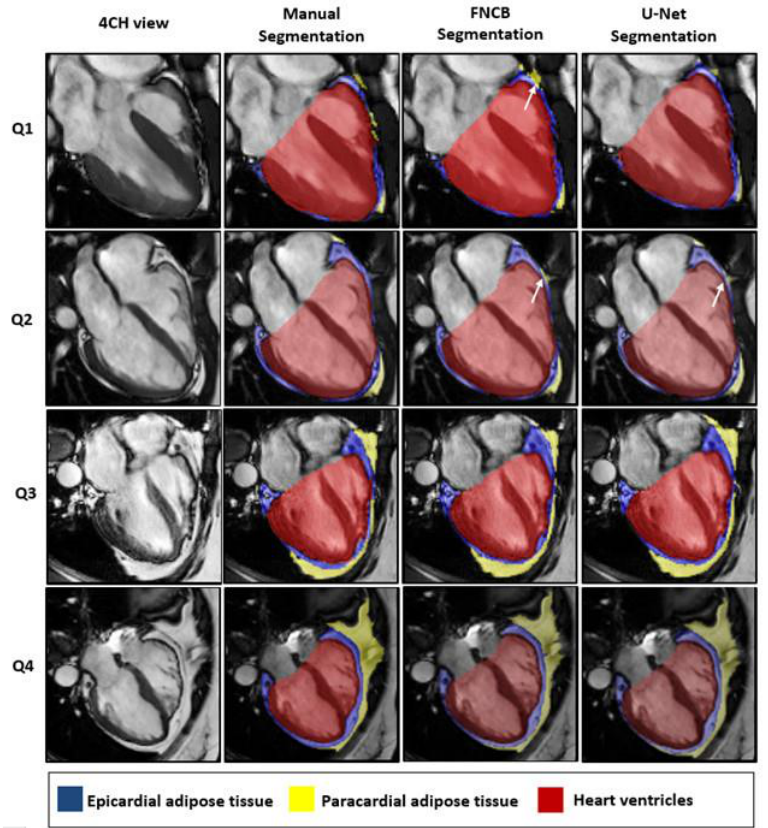
Figure 4. Representative segmentation results for each population defined by quartile of EAT area. Images were cropped around the heart for visualization. White arrows point out discrepancies between manual and automatic segmentations. As detailed in the methods, only periventricular EAT was segmented.